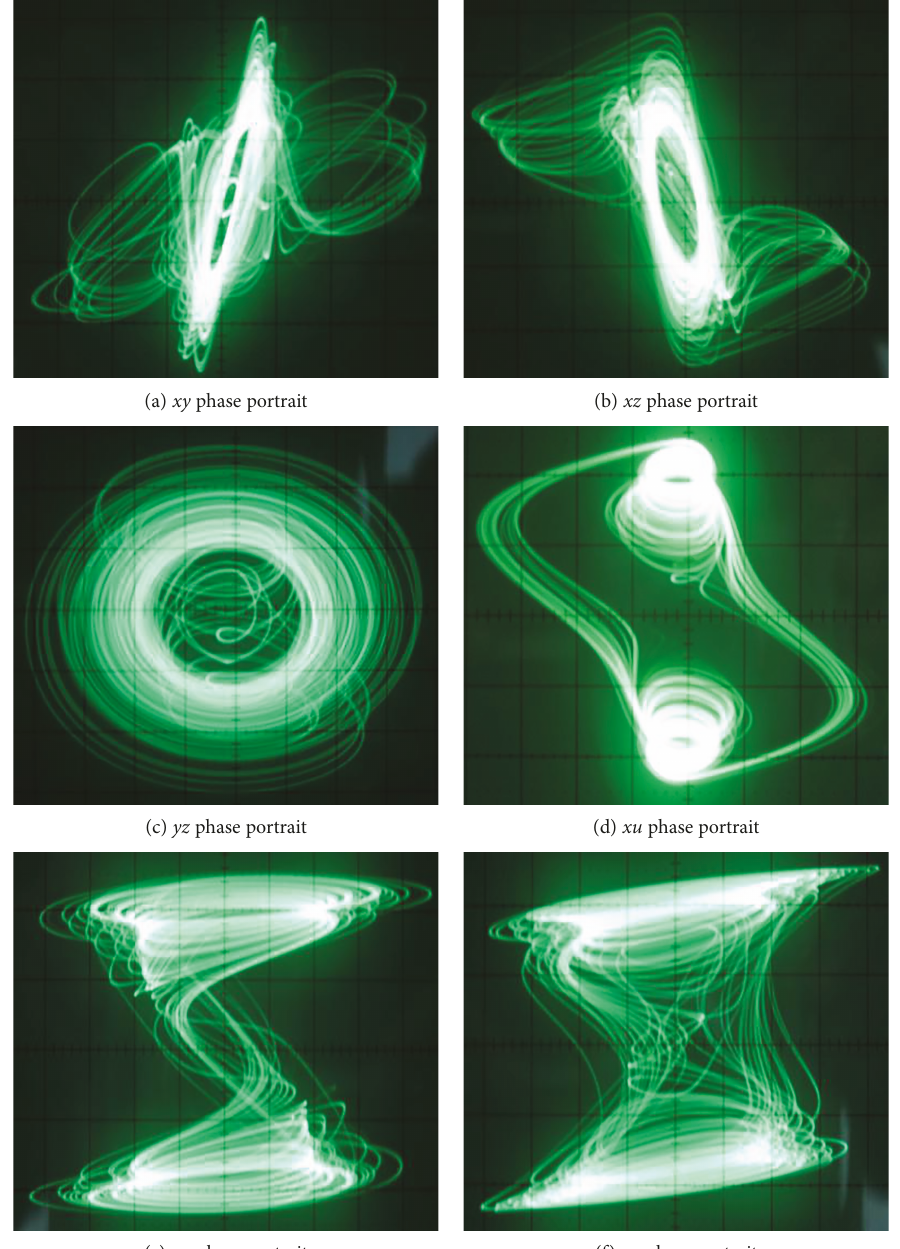
Figure 12: The output phase portrait photos.